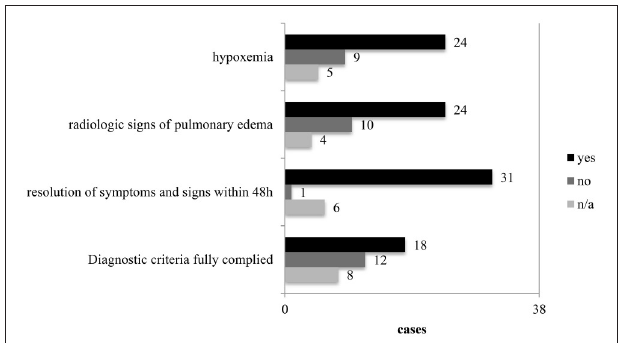
FIGURE 1 | Diagnostic key points in the 38